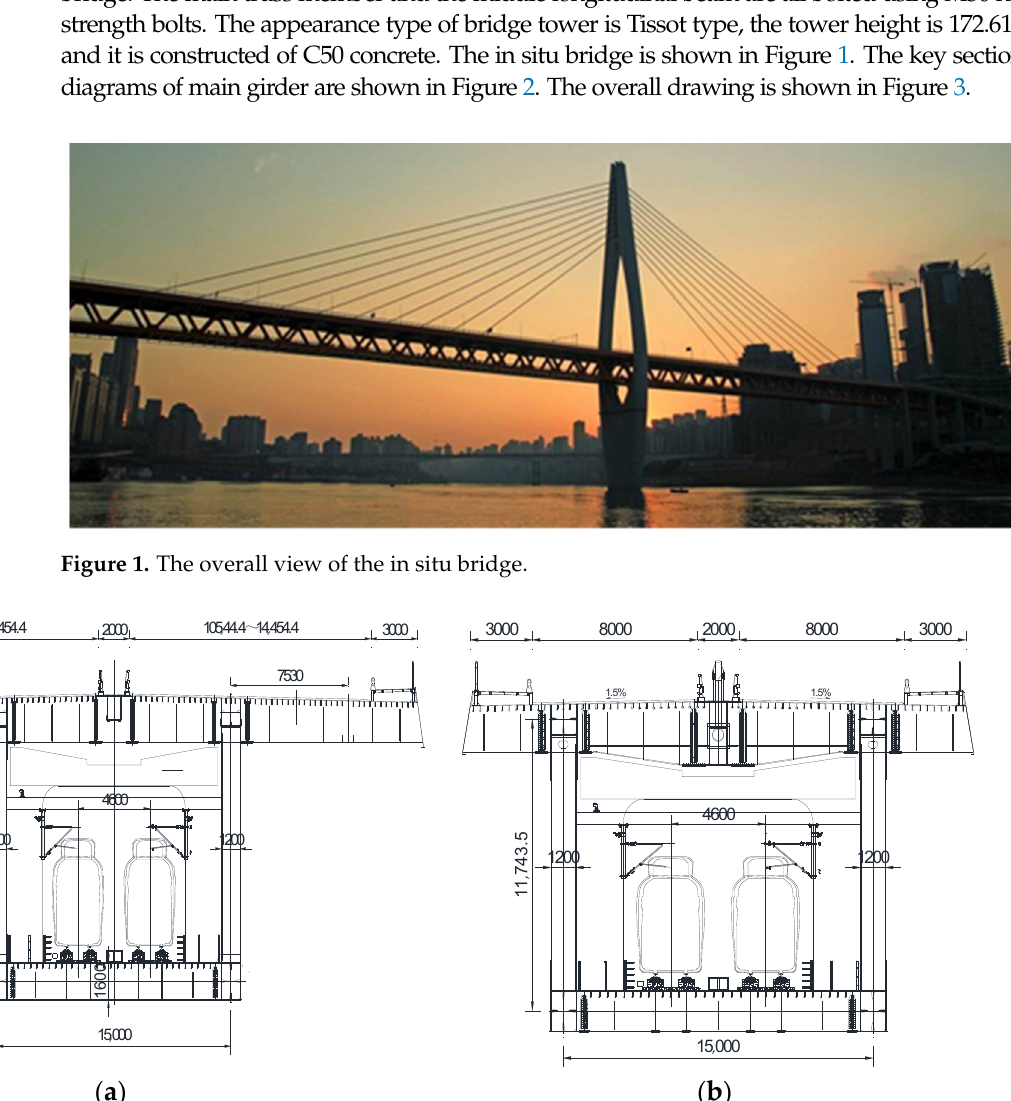
Figure 2. The key sectional diagrams of the main girder: ( a ) Section of main girder/mm; ( b ) Section of main girder cable area/mm.